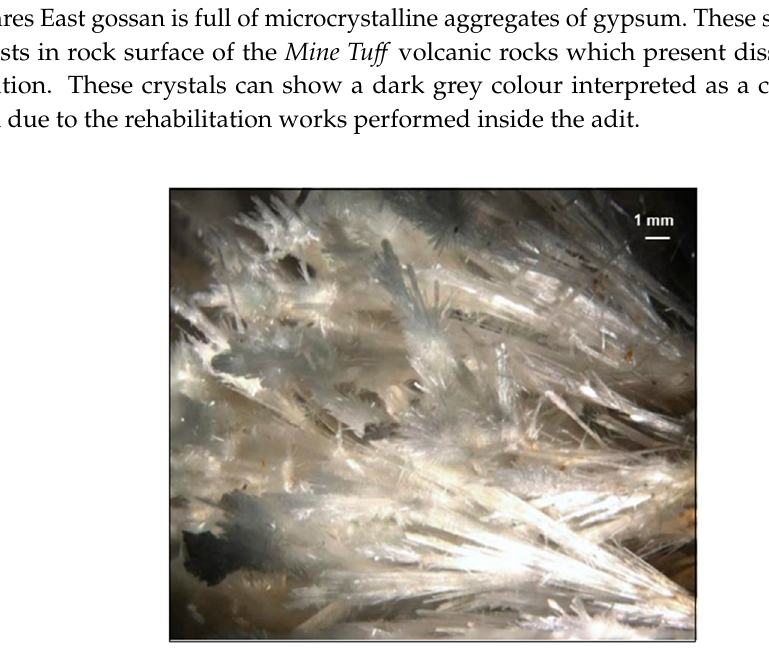
Figure 11. Stereomicroscope image of radial aggregates of gypsum in the Algares adit.